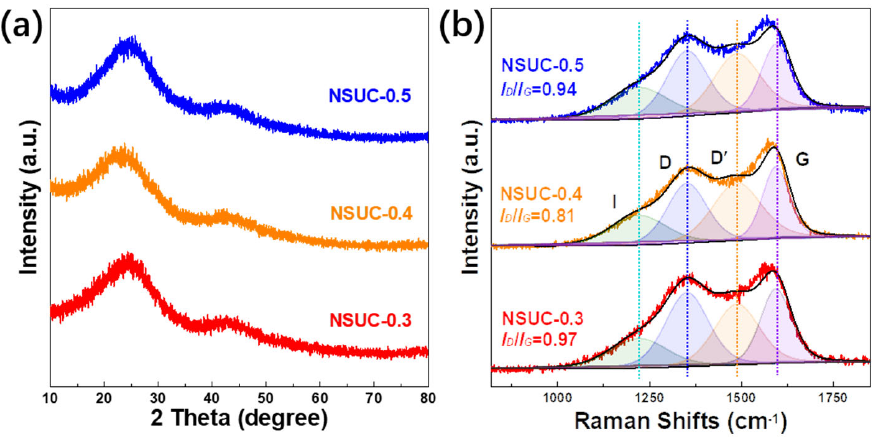
Figure 1. ( a ) XRD patterns and ( b ) Raman spectra of NSUC-x.